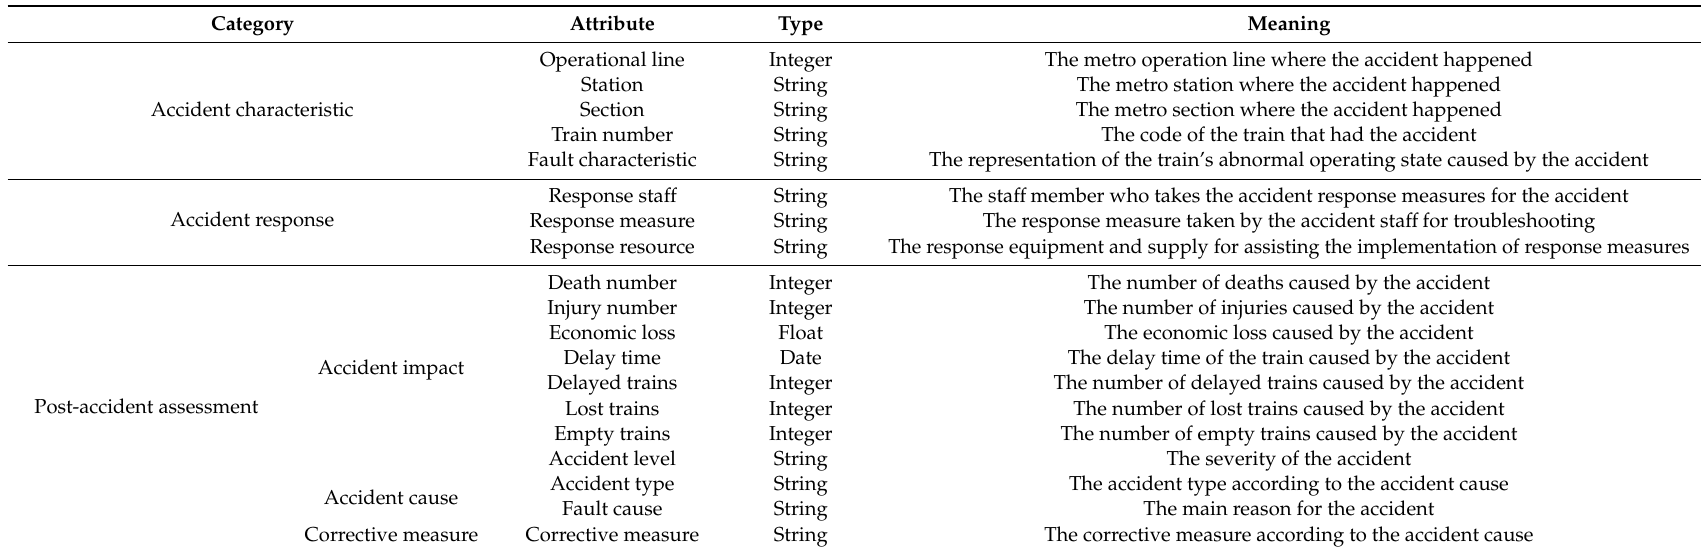
Table 2. The details of the main accident